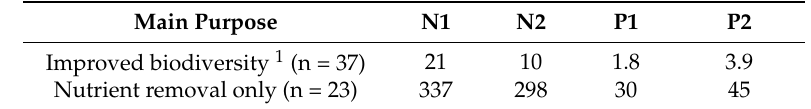
Table 2. Removal effects (kg nitrogen or phosphorus per hectare created wetland area and year) in wetlands granted support within the Swedish Rural Development Program 2007–2013, according to model calculations on 60 wetlands within the program, divided on the main purpose with individual wetlands as stated in decisions from authorities. Improved biodiversity was included as a main purpose, solely or in combination with nutrient removal, for 37 wetlands and nutrient removal was stated as the only main purpose for 23 wetlands. The models are designated as in Table